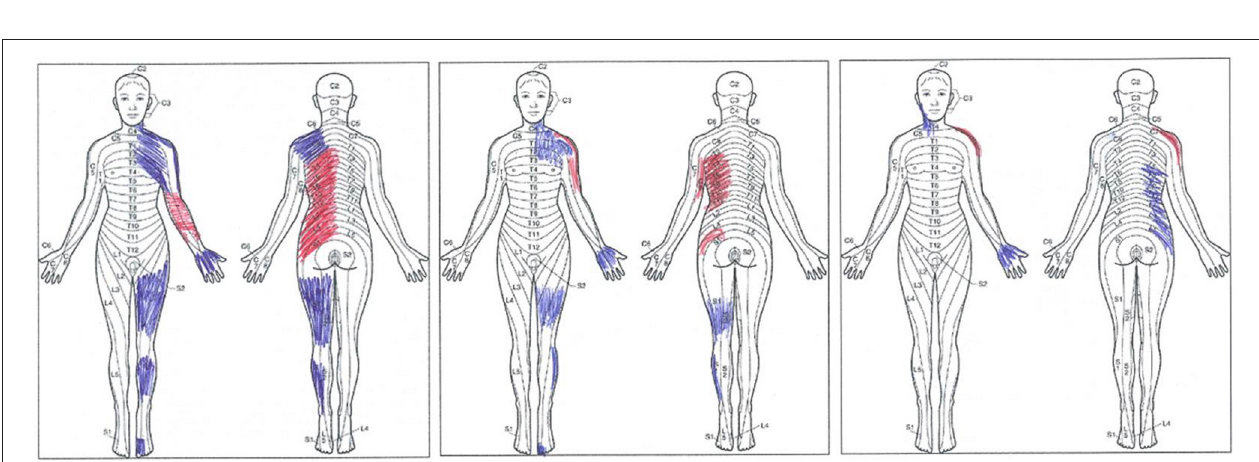
FIGURE 2 | The patient, at three time points, made original drawings. From left to right, drawings collected 40 days after the right thalamic stroke (T0), immediately after the last one of 10 repetitive transcranial magnetic stimulation (rTMS) treatments (T1), and 1 month after the last rTMS session (T2). Pain (red tract) and paresthesia (blue tract) are shown. Note that at T2, the patient acknowledged that she marked the “wrong” side of her body (right rather than left); nevertheless, the original drawing, performed with no cues from the examiner, is provided